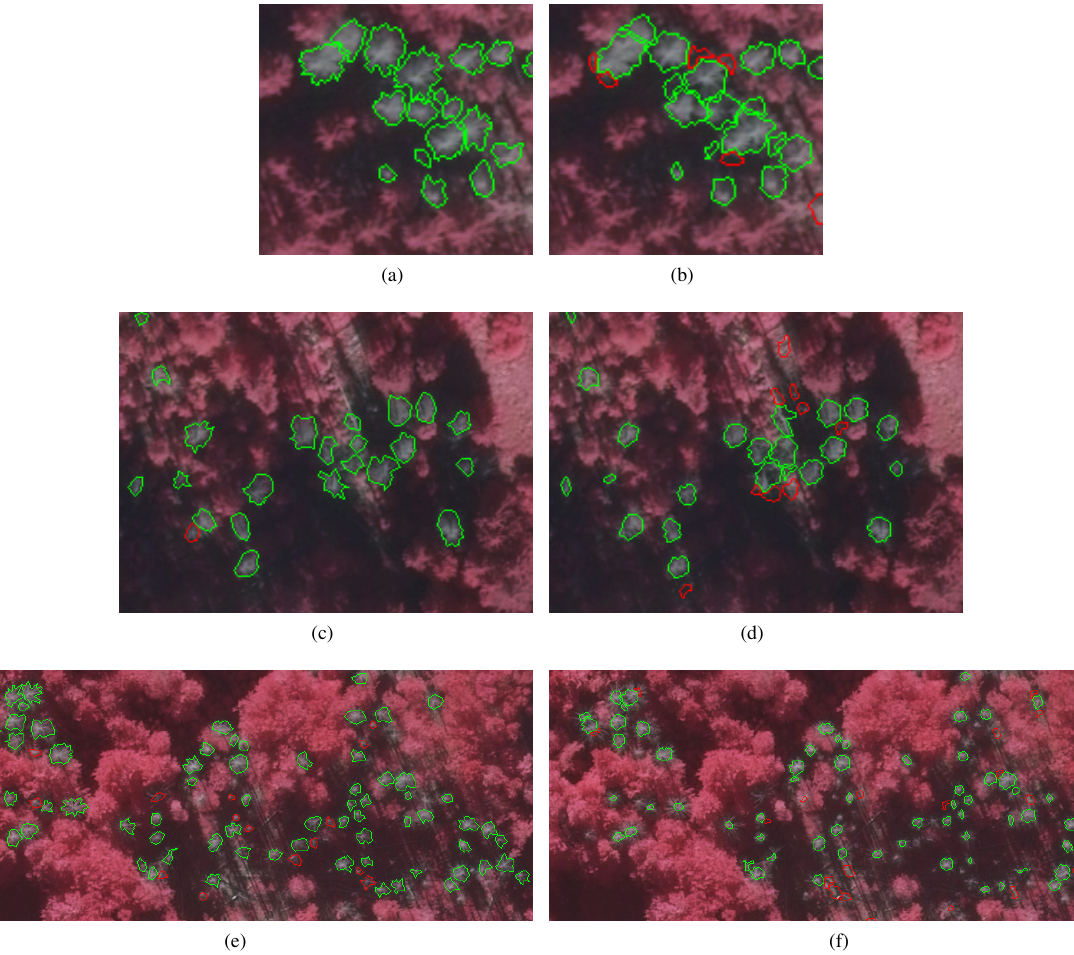
Figure 6. Reference and detected polygons. (a), (c), (e): reference polygons respectively of Plot 1,2, and 3. (b), (d), (f): detected polygons respectively in Plot 1,2, and 3. Red contours denote unmatched, green denote matched polygons using the 1-1 matching